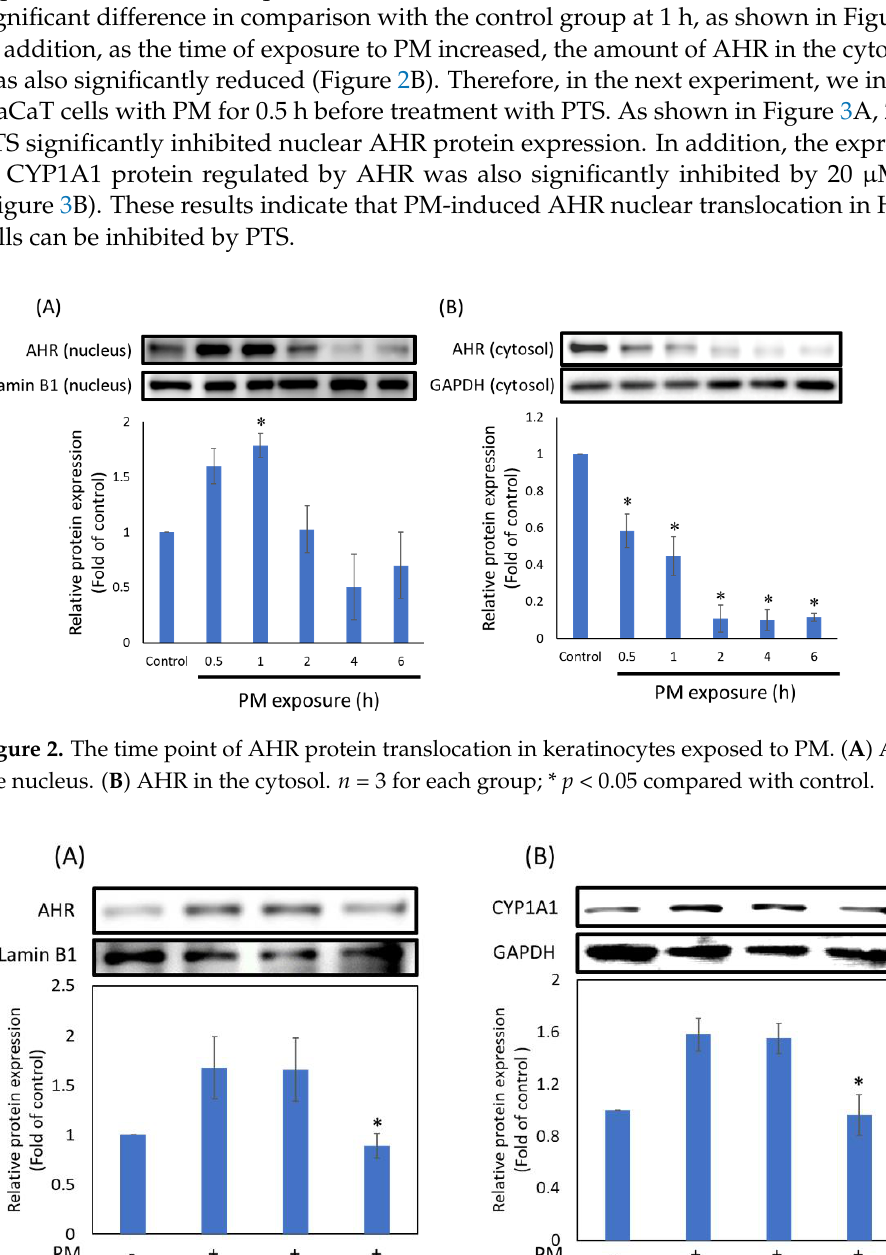
Figure 3. PTS inhibited AHR translocation and CYP1A1 expression. ( A ) AHR in nucleus and ( B ) CYP1A1 total protein. n = 3 for each group; * p < 0.05 compared with only PM exposure.